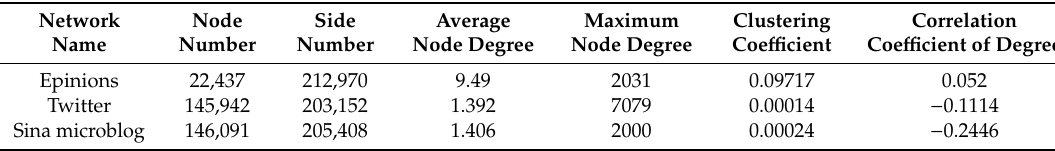
Table 2. Correlated characteristic parameters of each network.